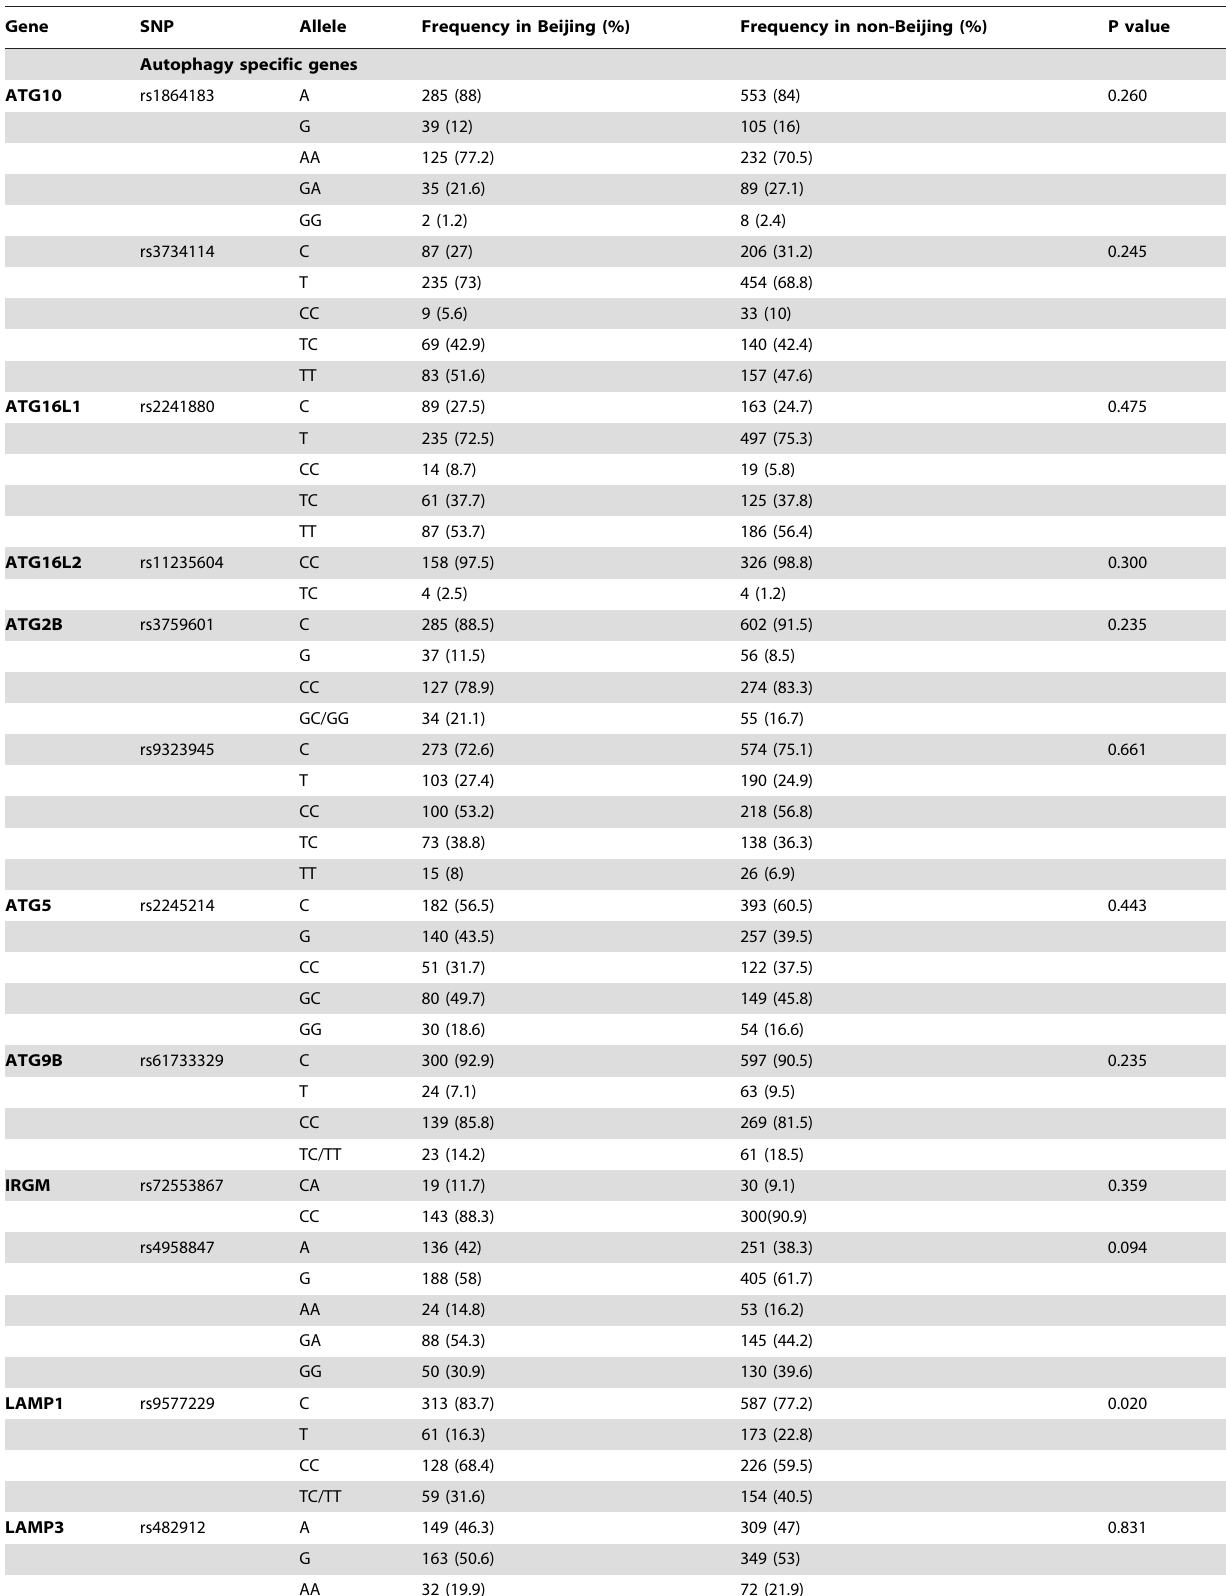
Table 4. Polymorphism in autophagy genes according to M. tuberculosis genotypes strain.